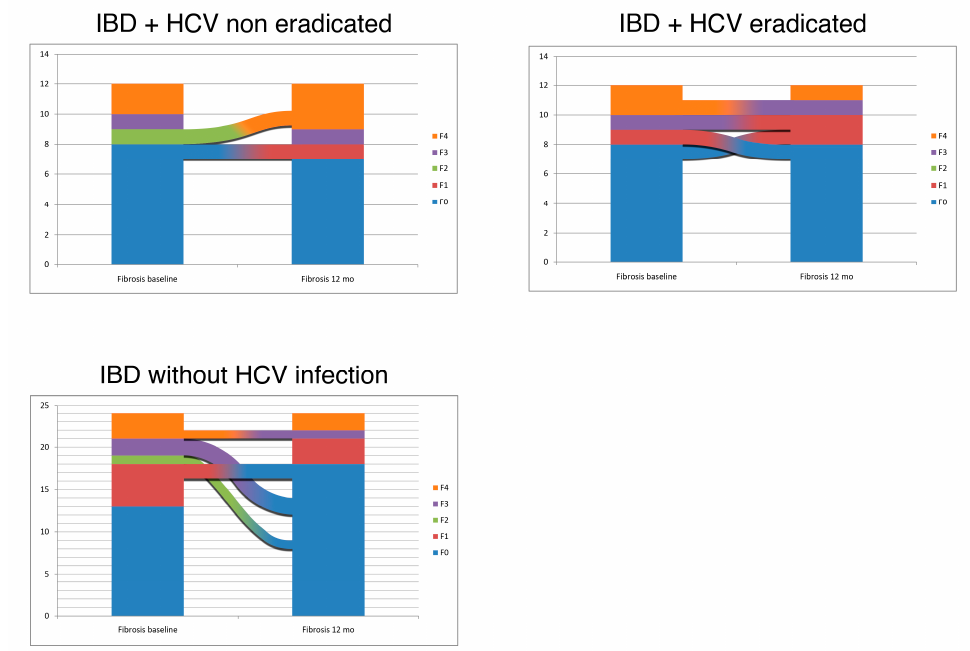
Figure 3. Variations in fibrosis severity stage across the 12 months follow up in the three groups of IBD patients. IBD